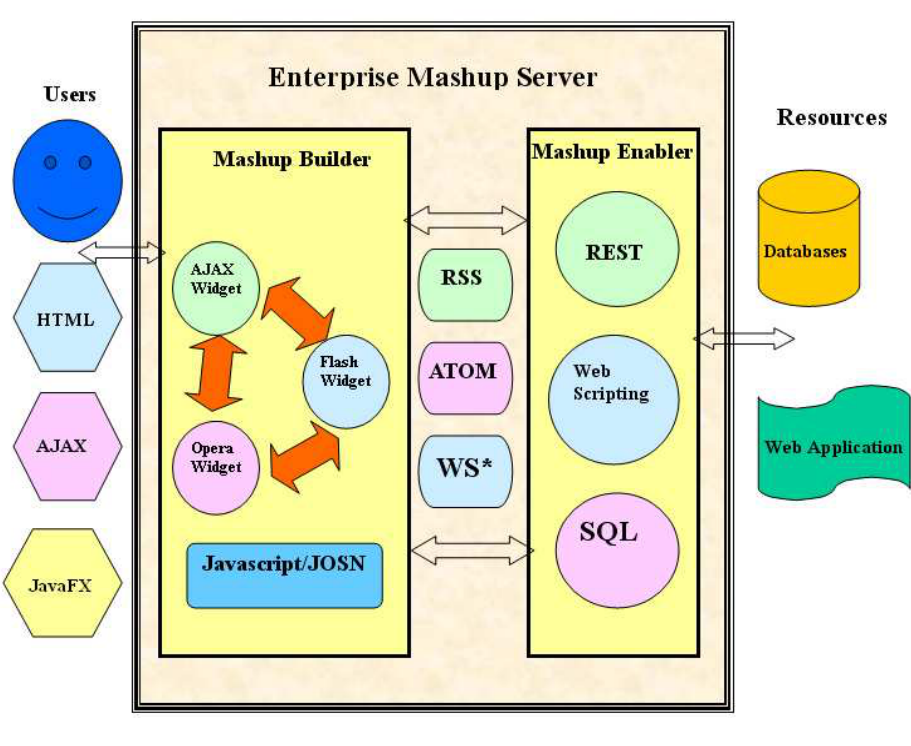
Figure 3. The Main Components of Enterprise Mashup